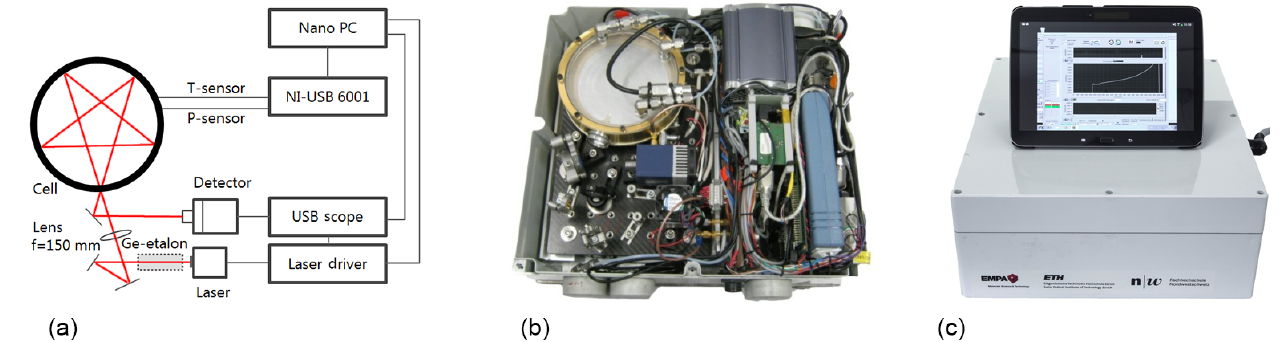
Figure 1. (a) Schematic of the instrument with the key optical and hardware elements. (b,c) Photograph of the QCLAS with the top cover removed and in the final layout. The overall weight is 10kg and it operates on 12V